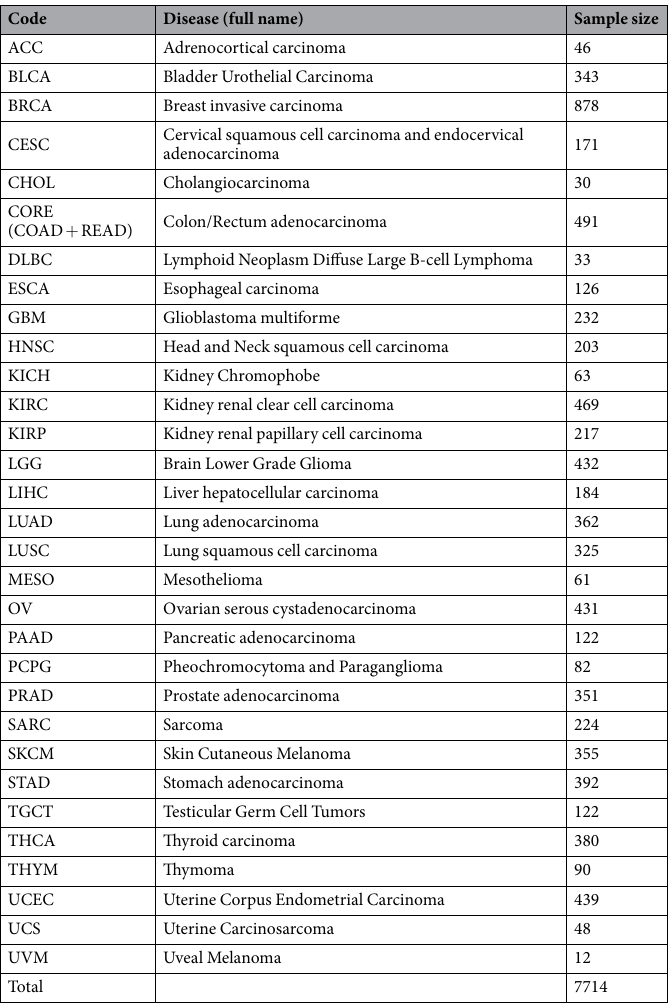
Table 1. TCGA tumor types and sample sizes in RPPA data (alphabetical